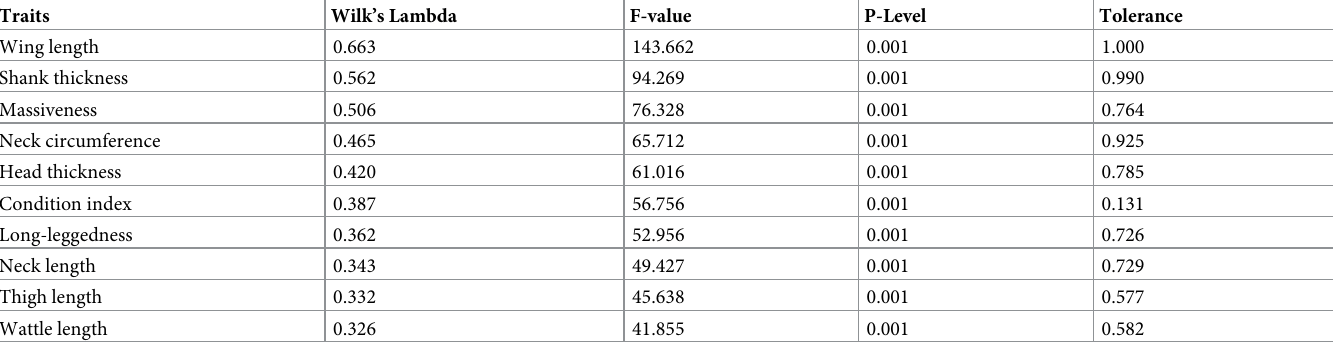
Table 6. Traits of importance in the discriminant analysis to separate birds in the three agro-ecological zones.